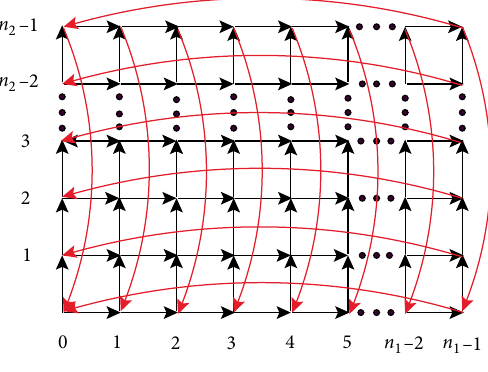
󳨀→ (cid:31) 󳨀→ 𝐶 𝐶 𝑛 1 𝑛 2